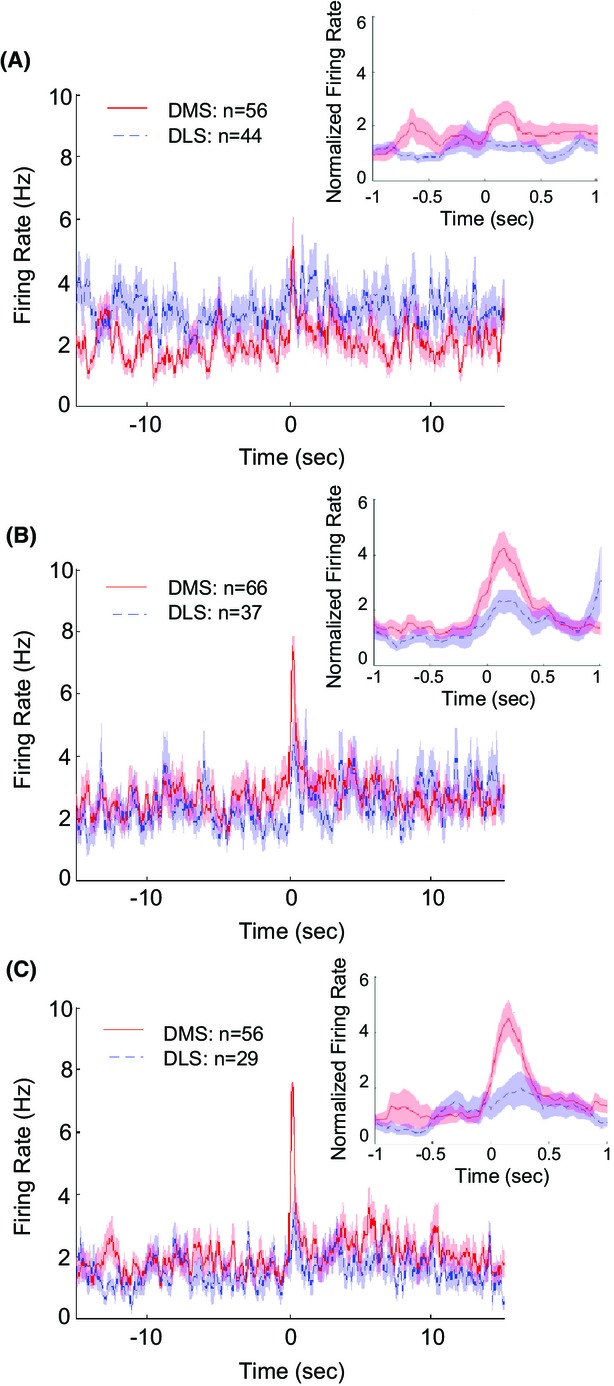
Neuronal firing rates (Hz) in the DMS (red, solid line) and DLS (blue, dotted line) averaged across the two cues and aligned to start-of-session cues (at 0 s). Mean firing rates (±SEM shaded) recorded during self-administration sessions following (A) saline, (B) 10 μg/kg SCH, and (C) 20 μg/kg SCH. Insets display a 2 s window to focus on cues (at 0 s), with the firing rate of each neuron normalized to the whole-session firing rate.